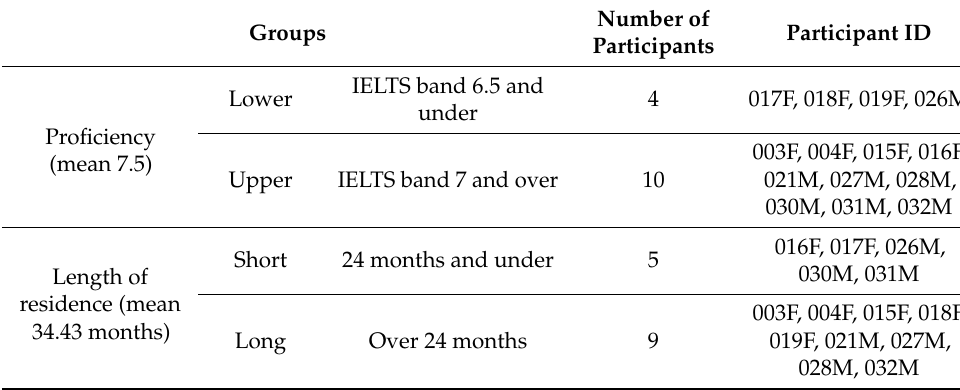
Table 4. Distribution of participants by LoR and proficiency.